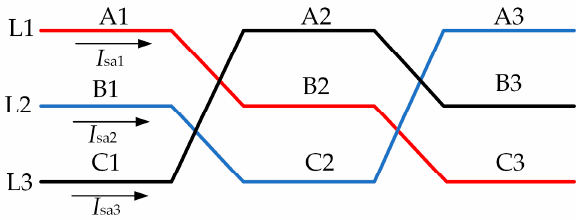
Figure 2. Schematic diagram of sheath current loops .